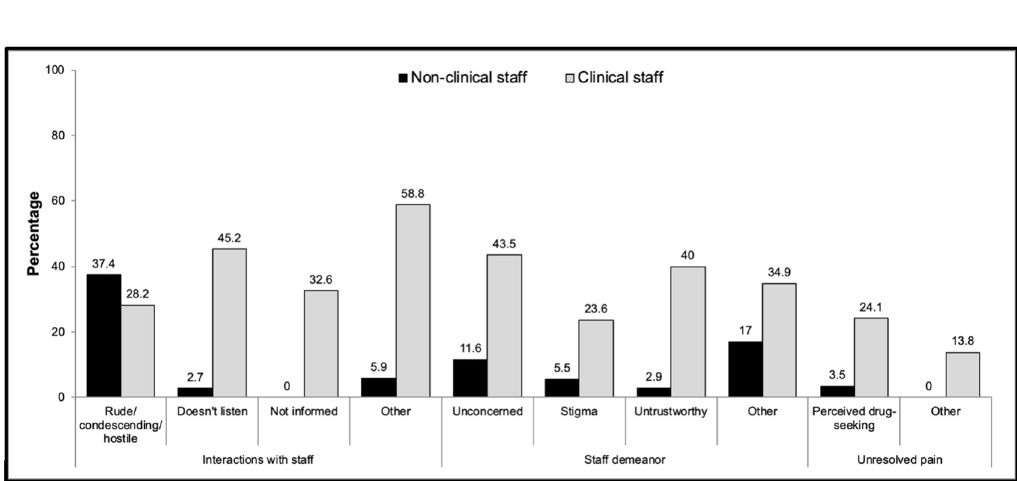
Fig 2. References to clinical and non-clinical staff when describing dissatisfaction with staff interactions, staff demeanor, and unresolved pain.